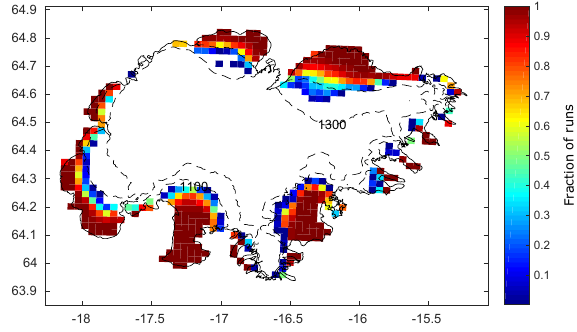
Figure 10. The fraction of the 1295 model runs where the grid points have exposed ice at some time during the summer.